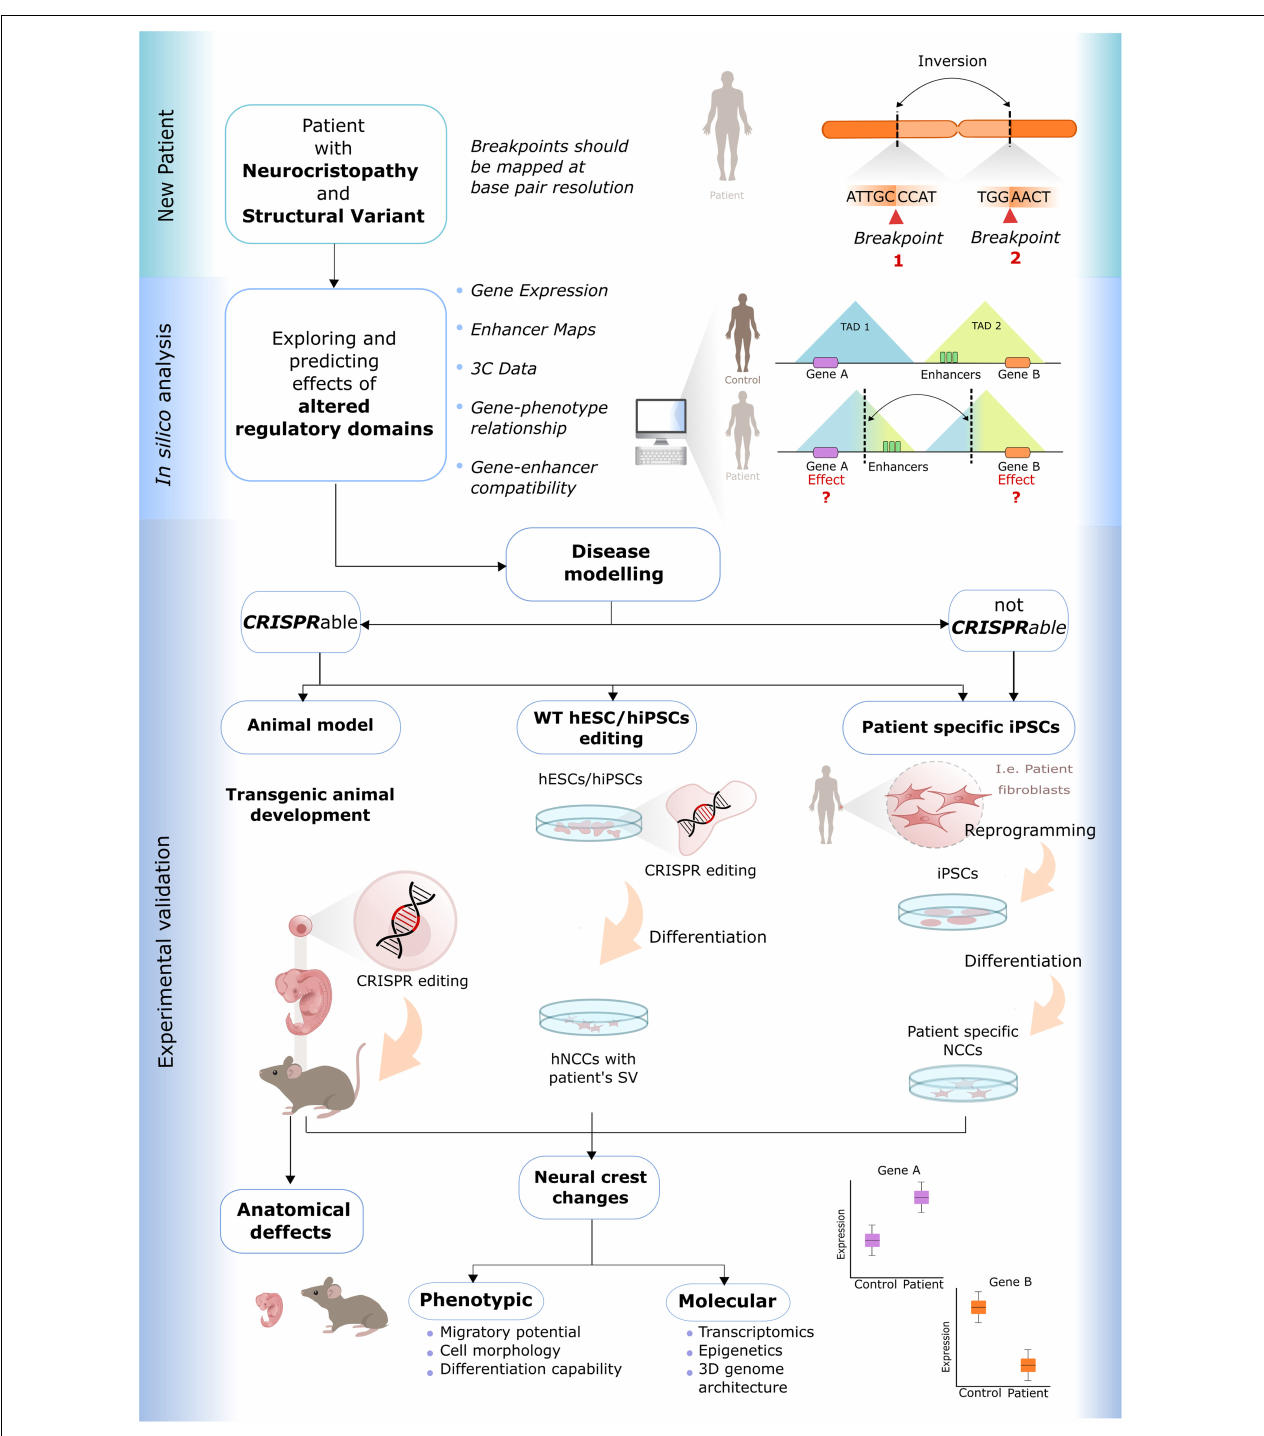
FIGURE 3 | Practical guidelines for the study of human neurocristopathies caused by structural variants. ( New Patient ) These guidelines can be used to study patients with neurocristopathies and structural variants (SV). ( In silico analysis ) The regulatory domains affected by the SV are identified with the use of publicly available genomic data, and the patient etiology can be predicted with the usage of ad hoc in silico tools. ( Experimental validation ) Two main experimental validation approaches can be followed. (1) If the SV is amenable to CRISPR-cas engineering (CRISPRable), the disease modeling can be done through (i) genome editing in animal models, if such models display the same gene dosage sensitivity as humans; (ii) genome editing of WT hESC/hiPSC; (iii) derivation of patient-specific hiPSC. (2) If the SV is not amenable to CRISPR-cas engineering (not CRISPRable), the derivation of the patient-specific hiPSCs is the only option. Once the previous disease models are established, a phenotypic and molecular characterization can be